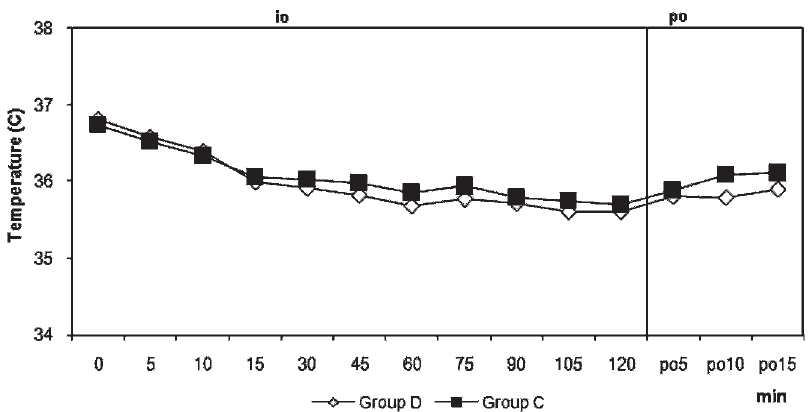
Figure 1 - Tympanic Core Temperatures. io: intraoperative, po: postoperative, min: minute, The tympanic core temperatures at each time interval were similar among the groups.